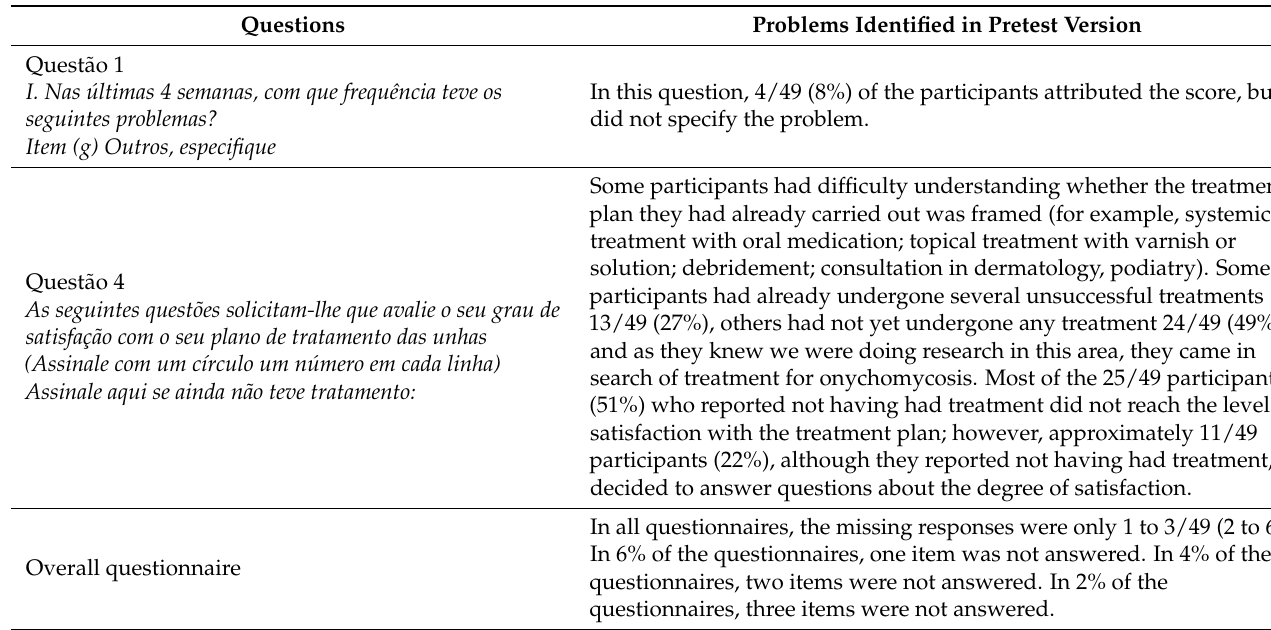
Table 6. After the pretest